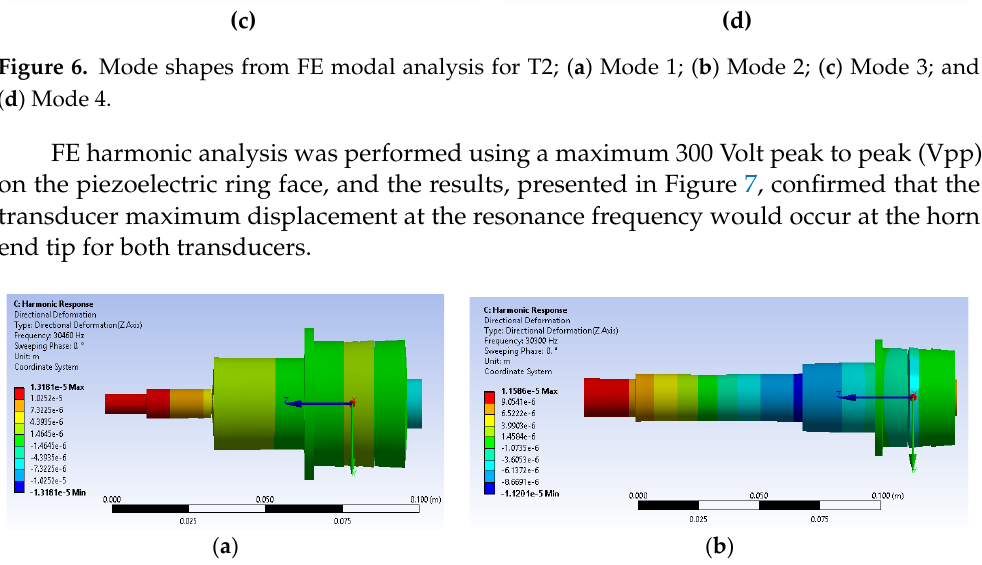
Figure 7. Axial displacement from FE harmonic analysis for; ( a )T1; and ( b ) T2. Design of the slider table and linear guideway: The dimensions of the slider table and linear guideway are assigned based on the dimensions of the workpiece, the base plate, the dynamometer (Kistler quartz 4-component type 9272), and the applied cutting forces affecting the system. Equation (1) is used to initially assign the dimensions of the slider table, given that the maximum force applied on it is 300 N [14,18–20]: